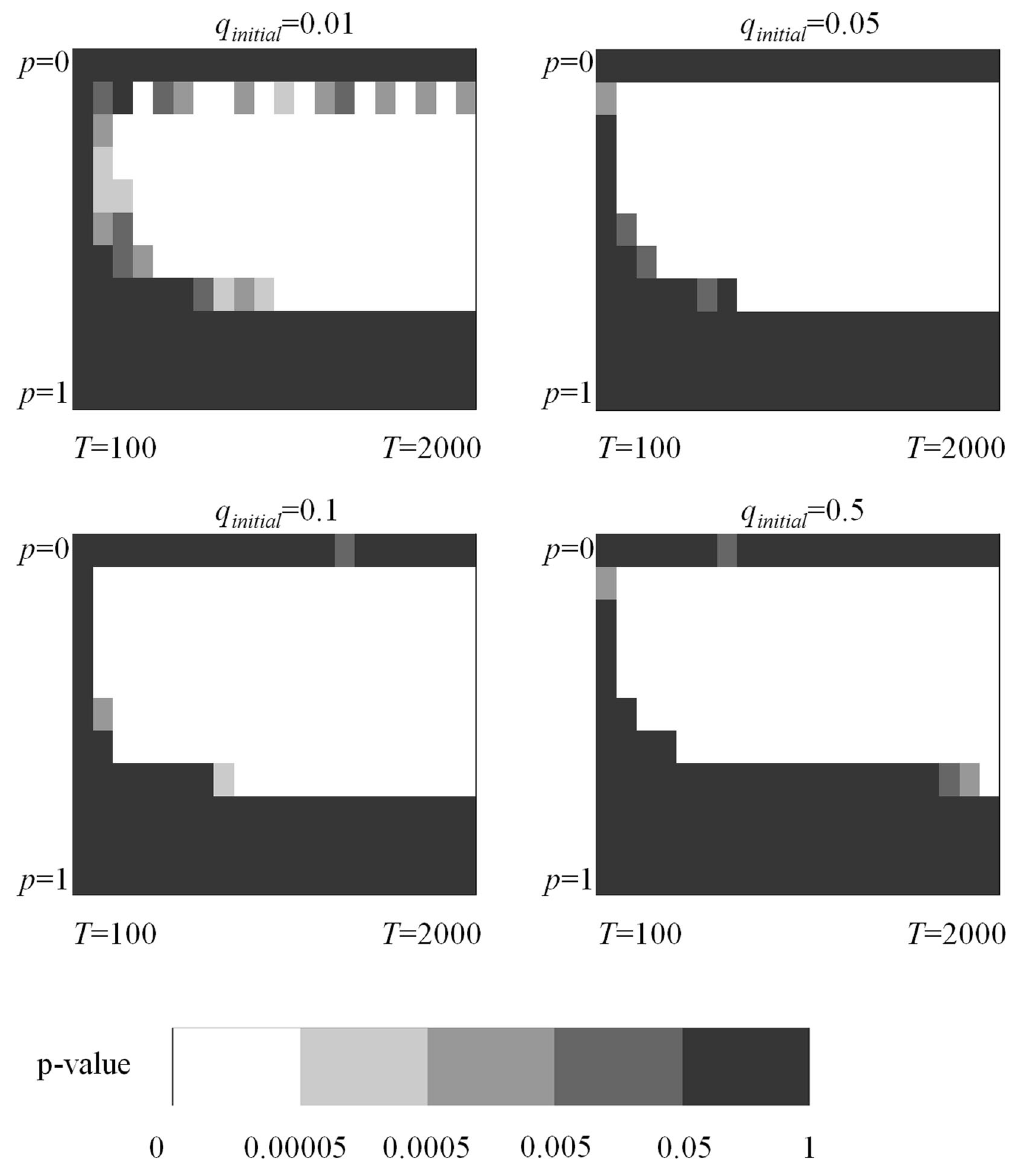
Fig. 14 The effect of different initial conditions, q initial , on model behavior. Explanation of the fi gure is exactly the same as in Fig. 4. Values for other parameters are: D = 0.002 , M = 1000, N = 20, Q = 1, S = 1, E =